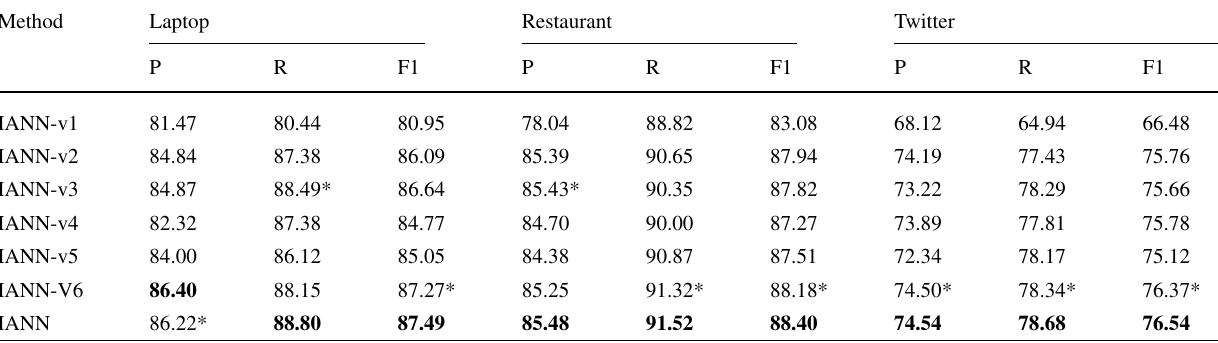
Table 3 The experiments of different variants on each dataset Method Laptop Restaurant